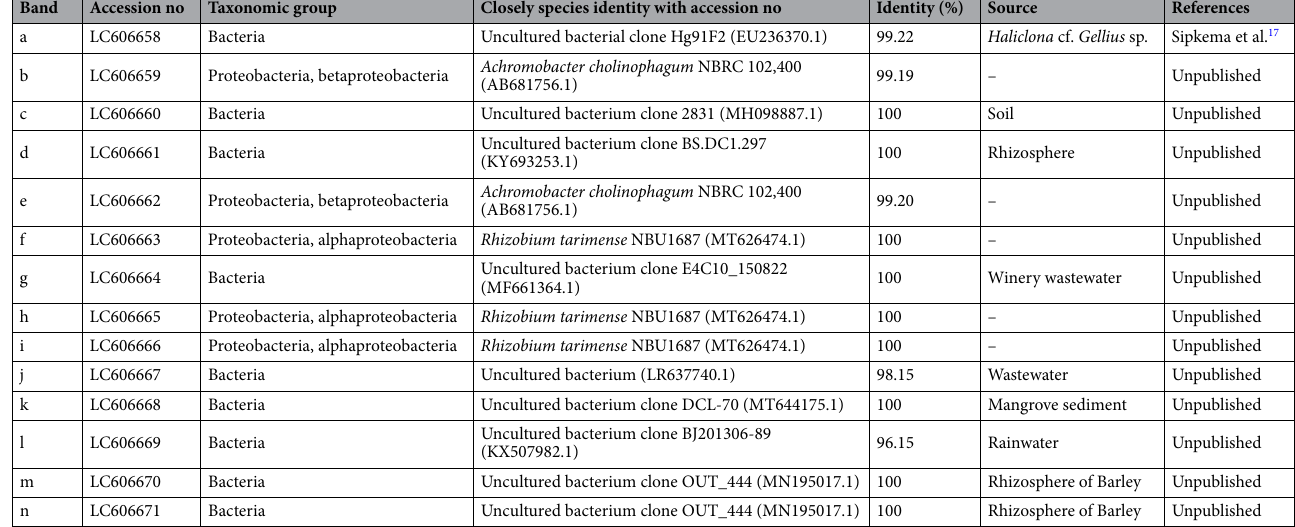
Table 3. Identification of rhizobacteria of ‘RD 6’ rice grown in saline soils based on the DNA sequences of bands presented in DGGE profiles which matched with sequences from GenBank database at the highest